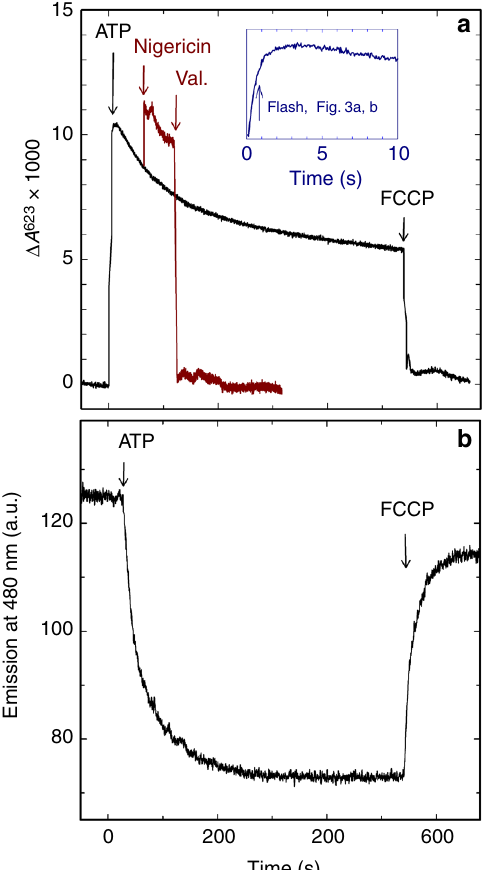
Fig. 2 Generation of an ATP-induced transmembrane electrochemical potential in SMPs. a The membrane electrical potential ( ΔΨ ) was monitored using the dye oxonol VI. The absorbance changes at 623 nm were measured as a function of time. ATP was added to the SMPs solution, containing oxonol VI, at t = 0 (black trace). The signal increased, consistent with proton pumping into the SMPs. Addition of nigericin after ~60 s (red trace) resulted in an increase in absorbance as the proton gradient ( Δ pH) was converted into an electrical potential. In the presence of valinomycin, (val., added after ~120 s) the absorbance decreased to the same level as that before addition of ATP (red trace). Addition of FCCP (at ~540 s) removes both ΔΨ and Δ pH (black trace). Mixing artifacts caused by the additions were removed for clarity. The absorbance changes were also resolved on a shorter time scale using a stopped- fl ow device (see inset in a ). The arrow indicates the time at which the reaction was started in the experiments shown in Fig. 3a, b. Experimental conditions: 0.1 mg SMPs in 1 ml buffer, 2 µ M oxonol VI, 1 µ M valinomycin. The fi nal ATP concentration was 160 µ M. In the stopped- fl ow experiment it was 1 mM. b Proton pumping to the interior of the SMPs (initiated by addition of ATP at t = 0) was monitored using the fl uorescent dye ACMA. As the inside of the SMPs became acidi fi ed the emission of the fl uorescent dye was quenched.